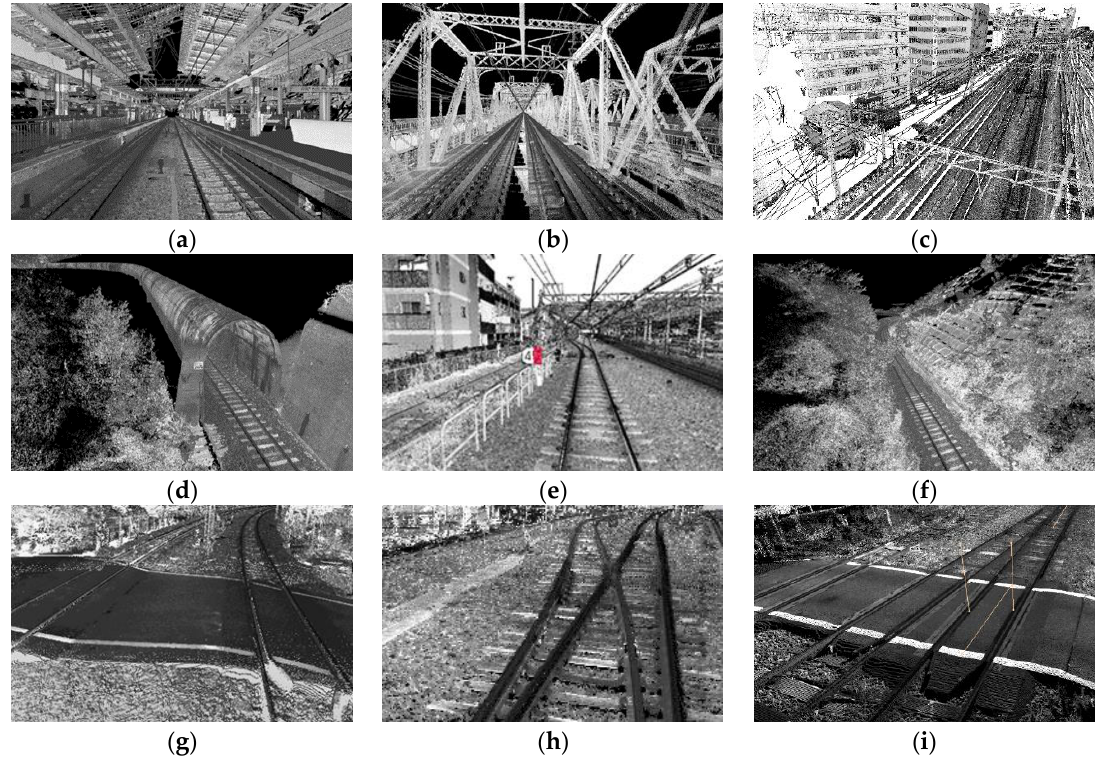
Figure 1. Point cloud acquired near to the railway: ( a ) station platform ( b ) bridge ( c ) catenary system ( d ) concrete tunnel ( e ) track bed in flat terrain ( f ) track bed in slope terrain ( g ) level crossing ( h ) turnout ( i ) multipel trackes during the mobile laser scanning (MLS) survey.